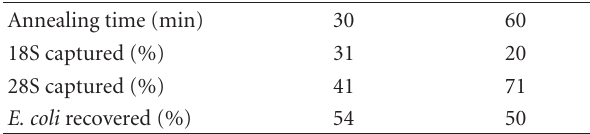
Note: The input RNA tested was 500 and 1000ng of mixed mammalian (98%) and E. coli (2%) RNA. Denaturation was performed at 72 ◦ C for 10 minutes and annealing at 50 ◦ C for 90 minutes.